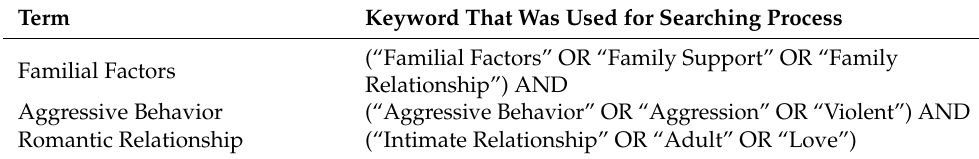
Table 1. Keyword Search List.